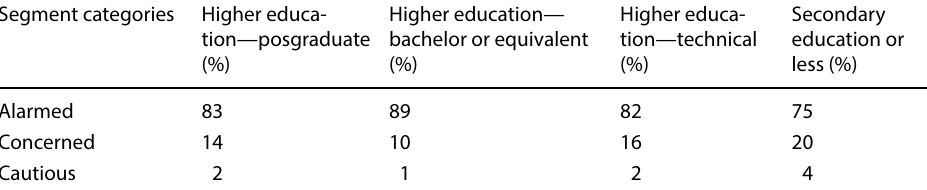
Table 4 Education level and audience